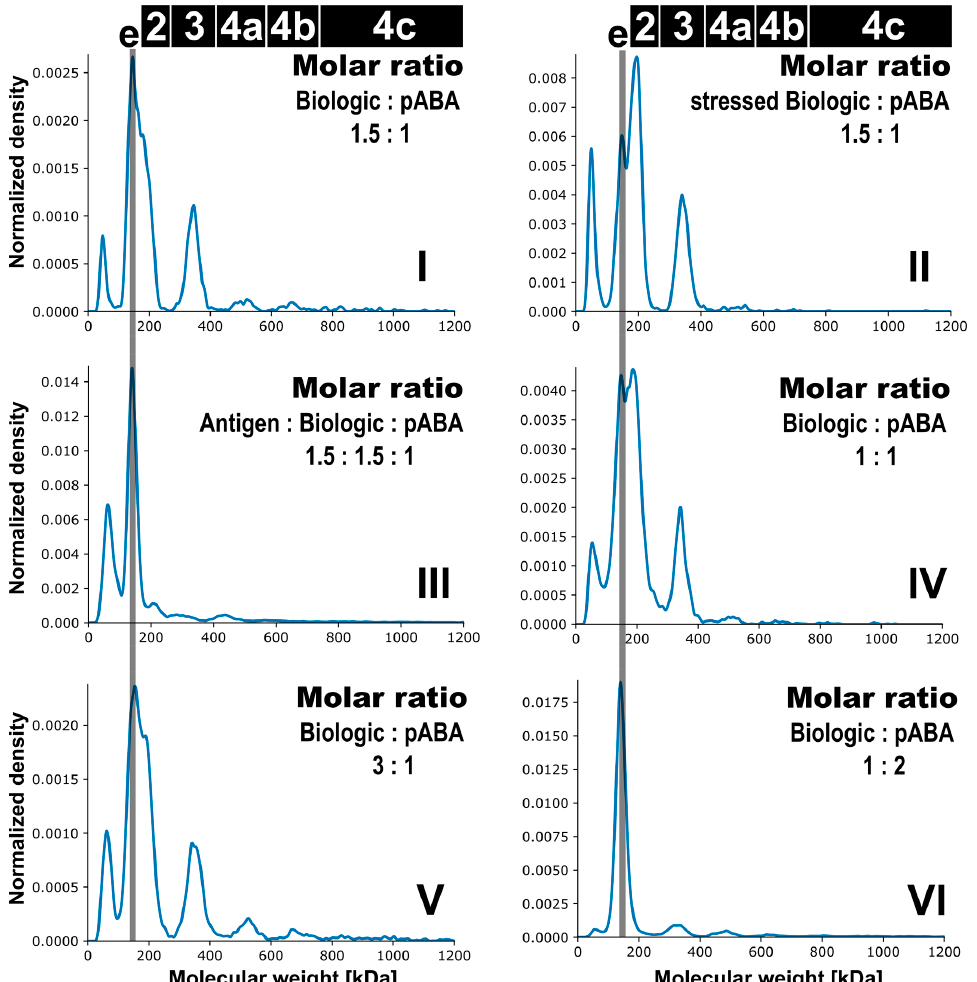
Figure 7. Analysis of immune complex formation at physiological concentrations. Mass photometry kernel density estimate profiles are shown for antigen:biologic:pABA compositions of the follow- ing molar ratios—0:1.5:1 on panel ( I ), 0:1.5 (stressed biologic):1 on panel ( II ), 1.5:1.5:1 on panel ( III ), 0:1:1 on panel ( IV ), 0:3:1 on panel ( V ), and 0:1:2 on panel ( VI ). Marker: (e) free pABA, (2) im- mune complexes with incorporation of a single ABA, (3) immune complexes with two incorporated ABAs, (4a) immune complexes with three incorporated ABAs, (4b) immune complexes with four incorporated ABAs, (4c) immune complexes with more than four incorporated